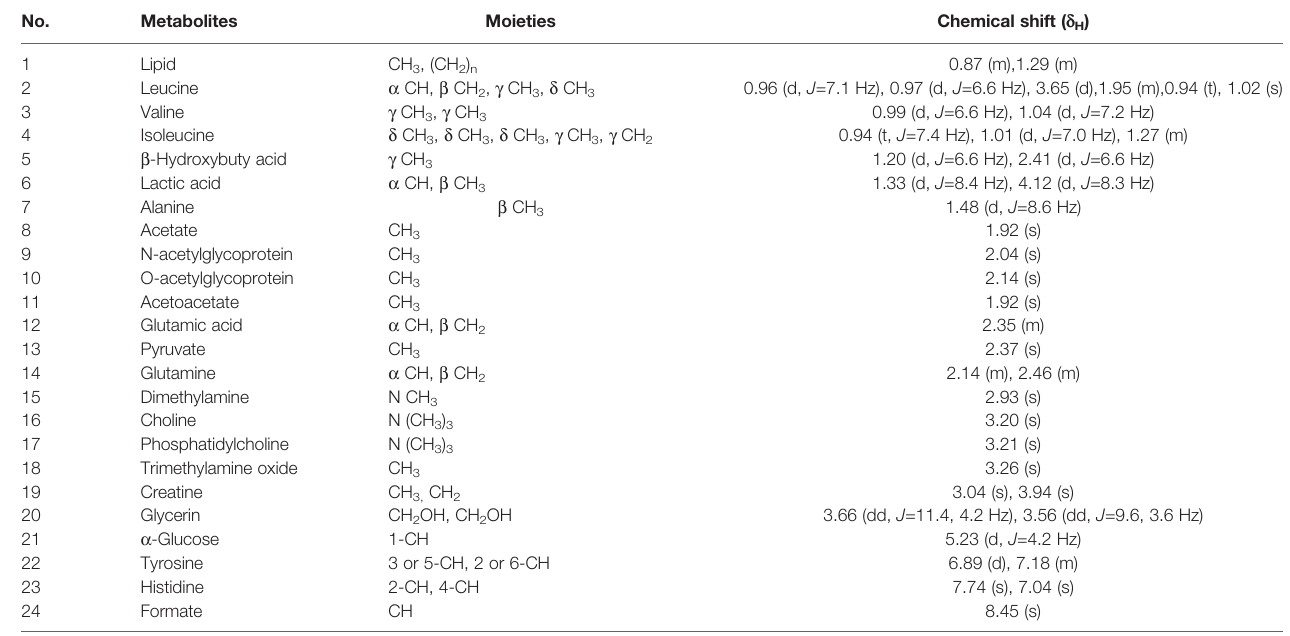
TABLE 2 | 1 H-NMR assignments of major metabolites in serum of rats.